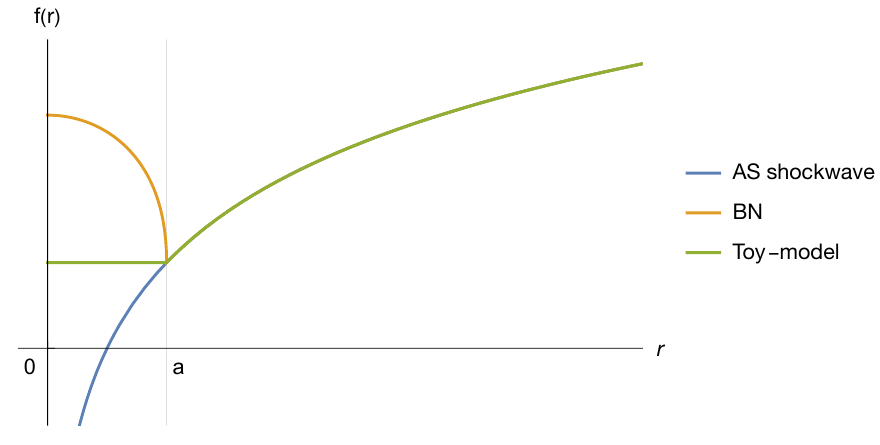
Figure 2 . Three different metric